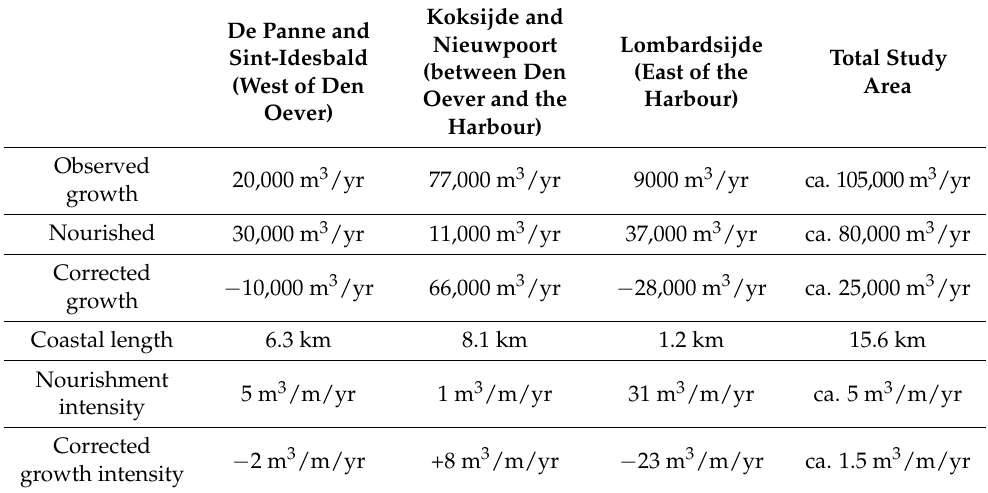
Figure 6. Distinguishing three parts in the study area based on sand balances. Table 2. Results from volumetric analysis. Sand balances for three sections (shown on Figure